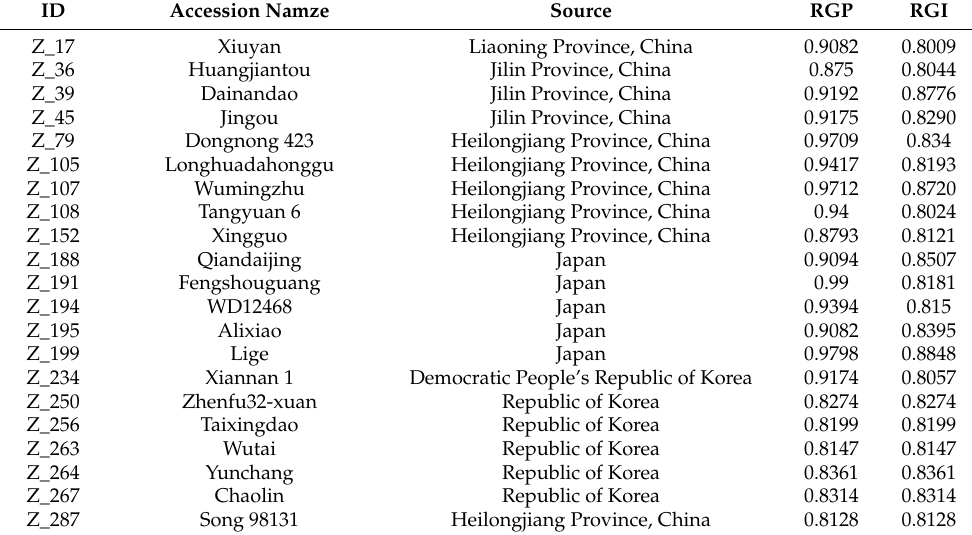
Table 3. Specific information of 21 high salt tolerance